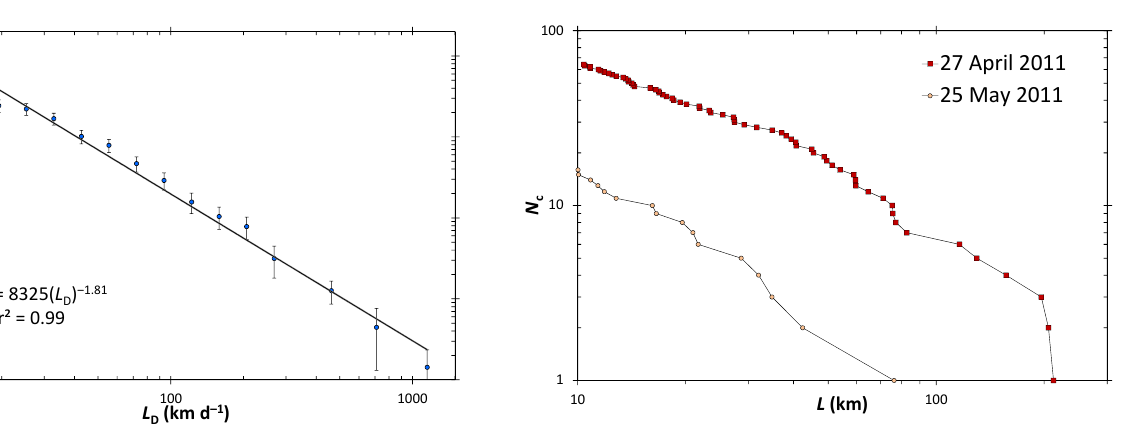
Fig. 16. Distribution of severe tornado ( L ≥ 10km) path lengths during two convective day (12:00–12:00 UTC) outbreaks in the continental USA. The cumulative number of severe tornadoes N c with path lengths greater than or equal to L , given as a function of L . Results are given for outbreaks on the 27 April 2011 (67 severe tornadoes) and 25 May 2011 (16 severe tornadoes). Tornado path length data L are from NOAA